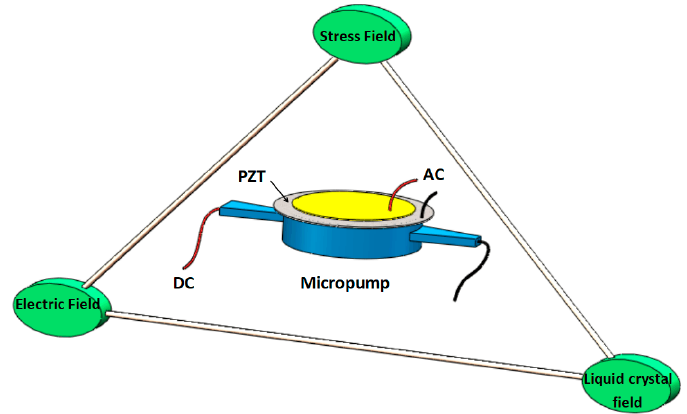
Figure 1. The schematic of the multifield coupling principal of liquid–solid–stress with LC and PZT combined driving by alternating electric (AC) and direct electric (DC) power supplies.